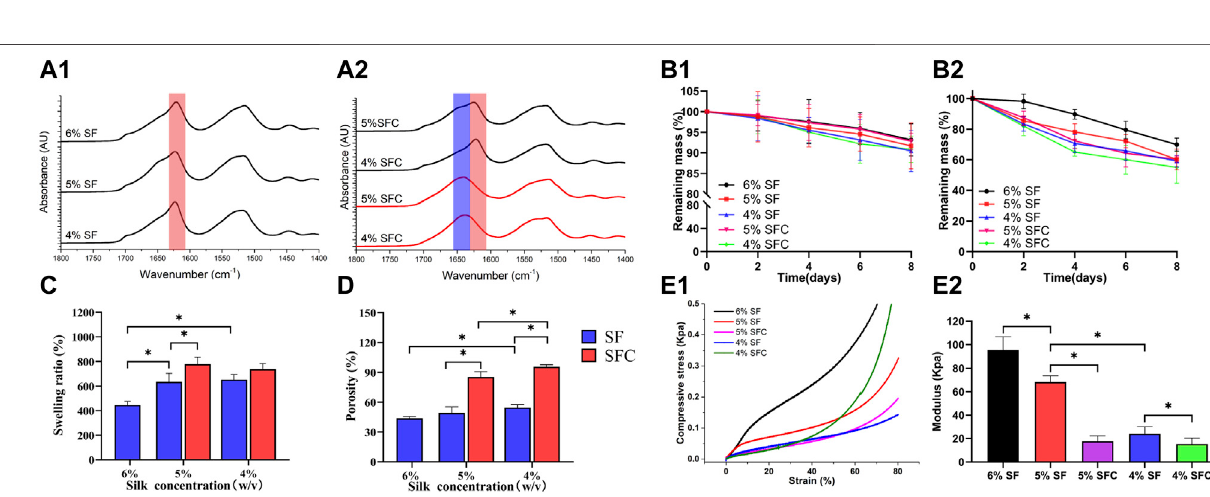
Frontiers in Bioengineering and Biotechnology |